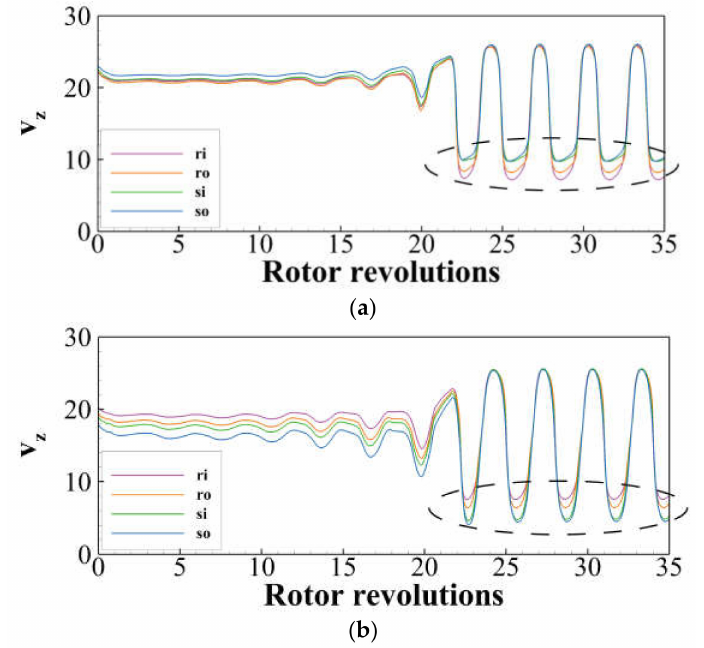
Figure 10. The variation of the axial velocity in the inlet and outlet of the rotor and stator row ( a ) at the tip, ( b ) at the hub. The dashed area represents the low-speed zone.